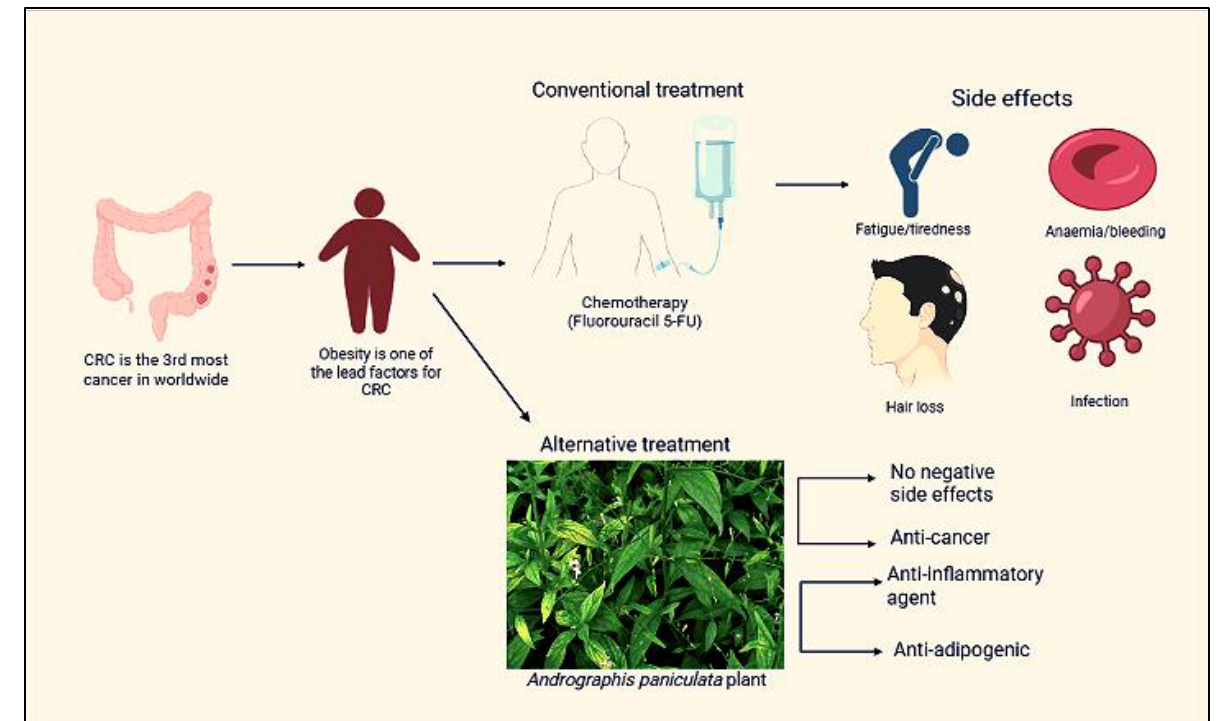
Figure 1. The summary of the study.